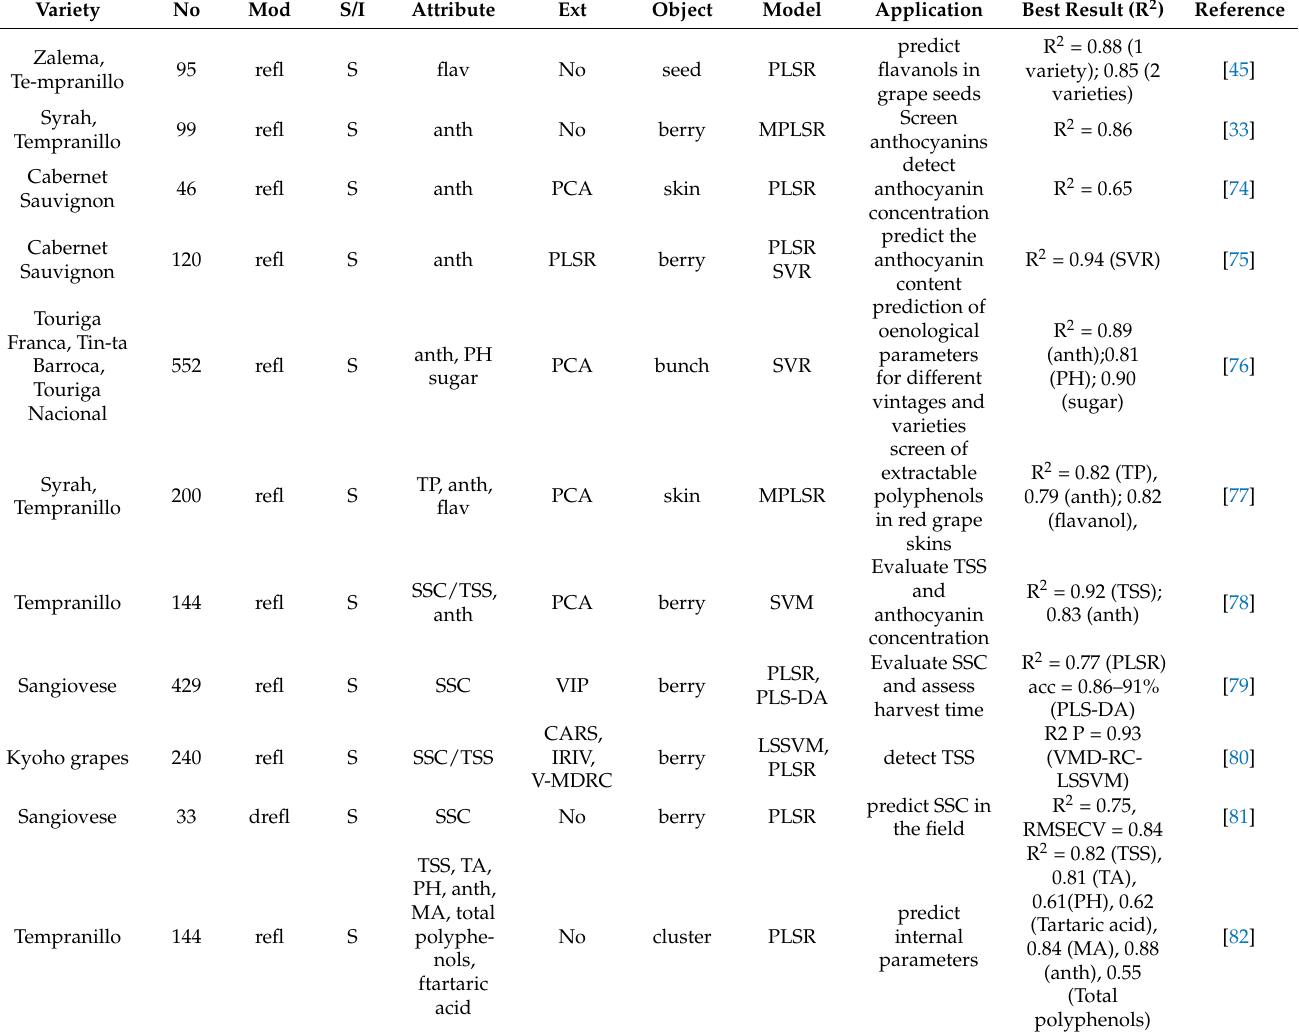
Table 6. Quantitative analysis of hyperspectral imaging (HSI) in